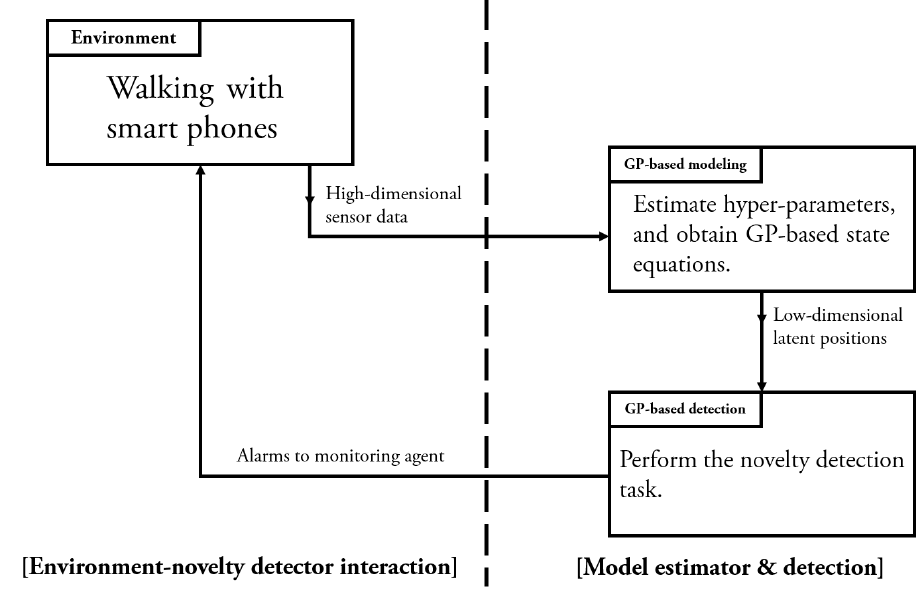
Figure 5. Experimental procedure for GP-based modeling and